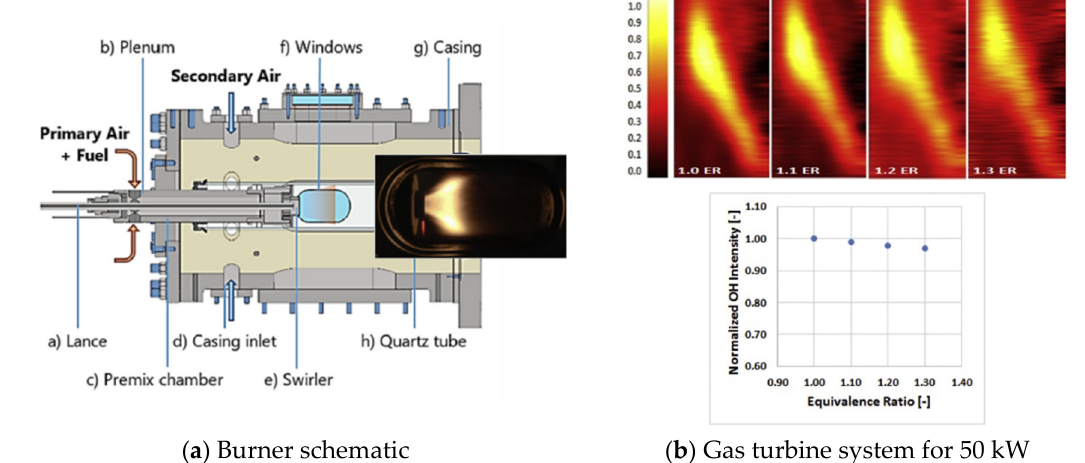
14 of 29 Figure 16. Experimental apparatus and direct photographs of flame with and without plasma: (a) Combustor; ( b ) and ( c ) are at φ = 0.94, ( d ) and ( e ) are at φ = 0.71. Courtesy of Elsevier [90]. 3. R&D Activities on Gas Turbine System 3.1. Lab-Scale Model Burner for Ammonia-Rich Mixture Combustion A research team from Cardiff University in the UK worked on an ammonia gas tur- bine [97–100]. The superiority of ammonia as a storage material for hydrogen and the possibility for direct combustion was evaluated. Finally, they announced that an ammo- nia-hydrogen dual-fuel approach will be applied in their facility, with the hydrogen gen- erated in a pre-combustion ammonia cracking step. Valera-Media et al. conducted an ex- periment for stable combustion operation when hydrogen was added using a 70% NH 3 - 30% H 2 (mol%) blend [97]. Figure 17 shows an optical generic swirl-burner and OH* intensity results. Under